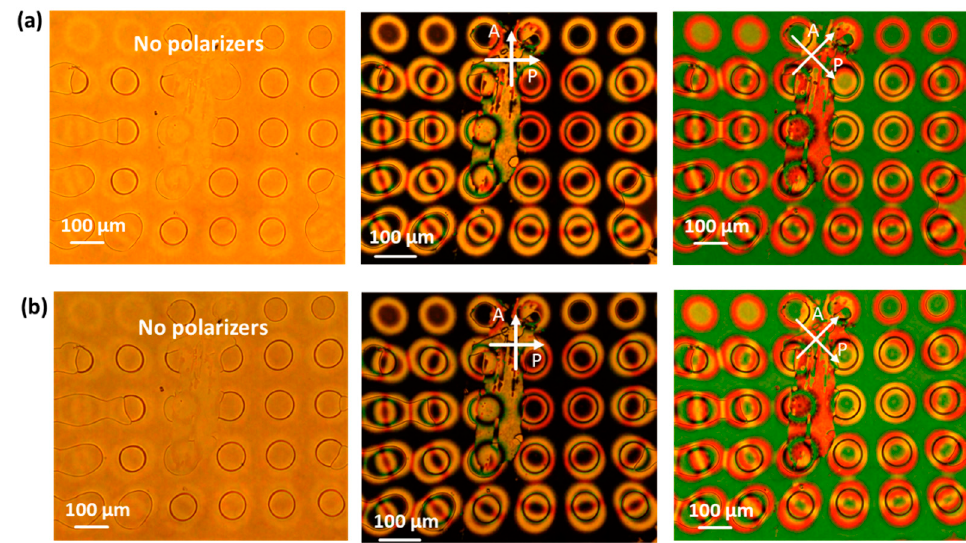
Figure A1. Microscope images of the cell (0V) in a patterned area where the centra of the patterned rings at the top and bottom substrate overlap at some positions. The same area of the cell is shown as in Figure 1, but these images here are taken 3 months after filling the cell: without reapplying a voltage in ( a ) and after applying (and removing) a voltage of 10 V pp in ( b ). The dimensions of the patterned rings are r out = 50 µm (r in = 0.4 * r out ). The transmission is show without polarizers and for two different orientations of the crossed polarizers.